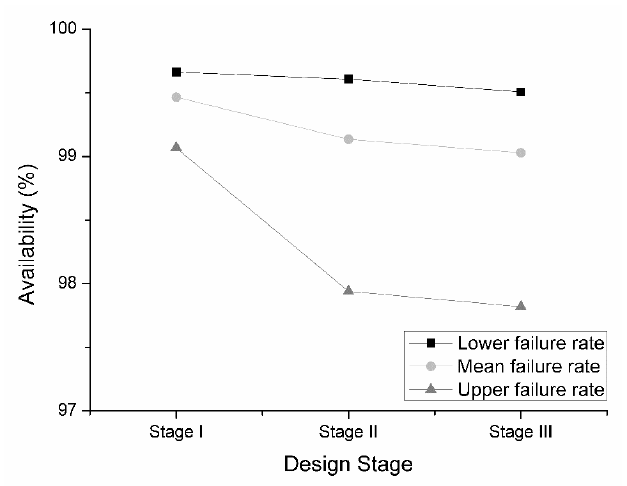
Figure 16. Availability with additional repair time.